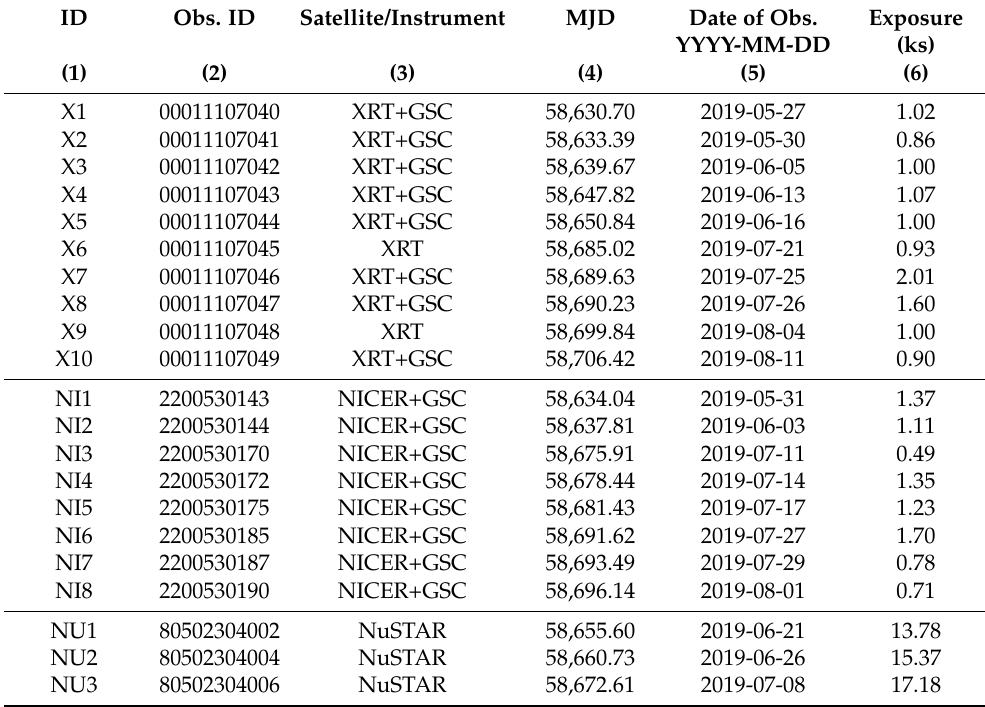
Table 1. Log of Swift, NICER and NuSTAR observations of the transient BHC MAXI J1348-630. ID Obs. ID Satellite/Instrument MJD Date of Obs.